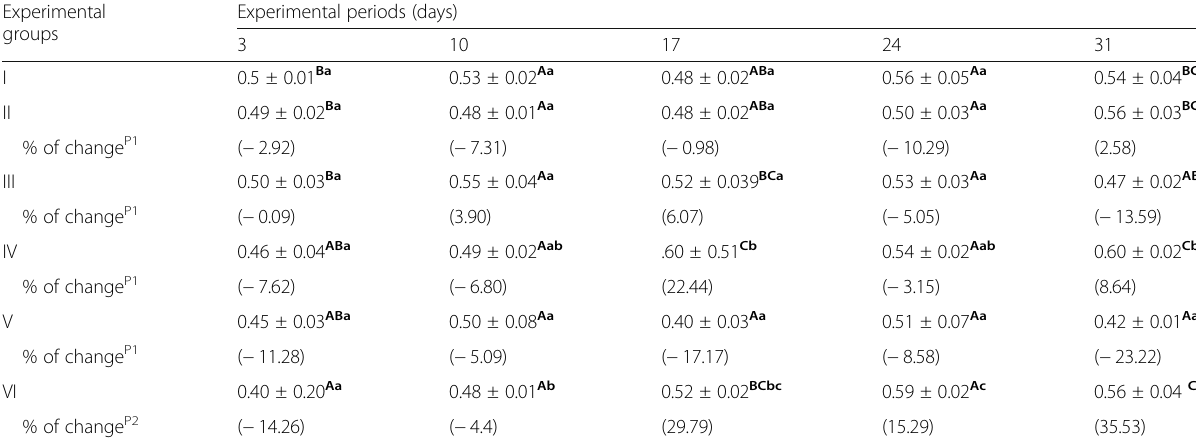
Table 4 Monocyte count (10 9 /L) in the experimental groups at the experimental periods Experimental Experimental periods groups